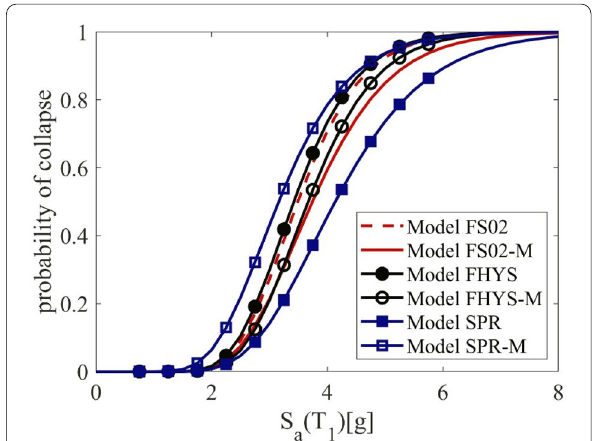
Fig. 16 Collapse fragility functions for all modeling choices for hazard-consistent ground motions (GM Set